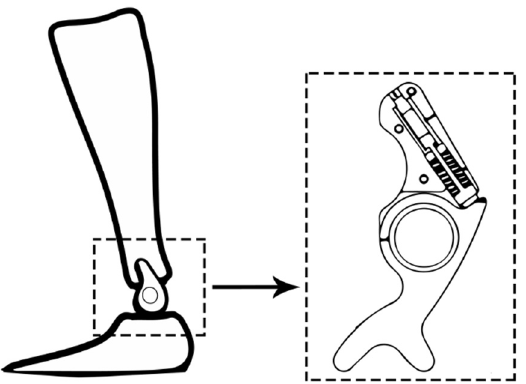
Figure 5. AFO with an oil damper [55]; with permission from Elsevier (License Number: